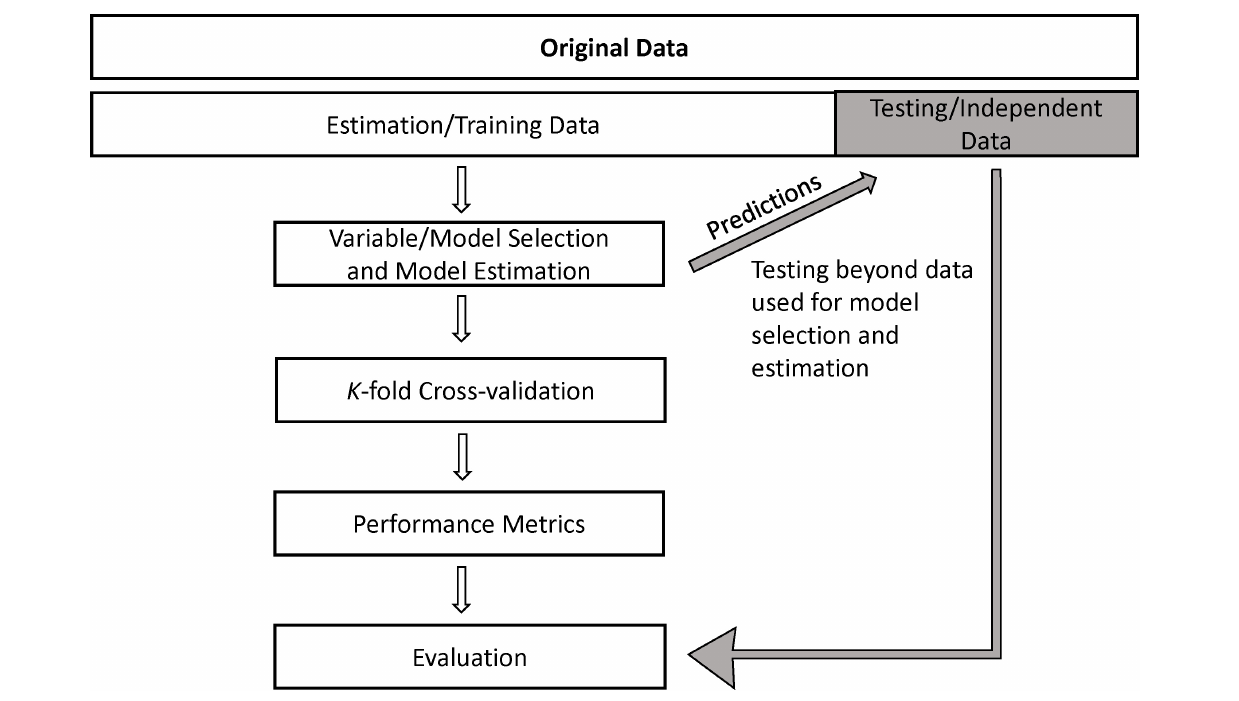
FIGURE 6 | The original (full) data set is split into training (estimation) and testing sets, prior to variable and model selection and parameter estimation. Predictions from the model fit to the training data are then made for the testing data. Evaluation of the correspondence between predictions and testing data is combined with internal evaluation of the training data using k -fold cross-validation. In computer science and engineering disciplines like machine learning, k -fold cross-validation can lead to model refinements (Broms et al., 2016), which can then be re-tested using cross-validation. However, predictions should be made to the holdout testing data only after a final model has been reached, and not during the model selection or refinement